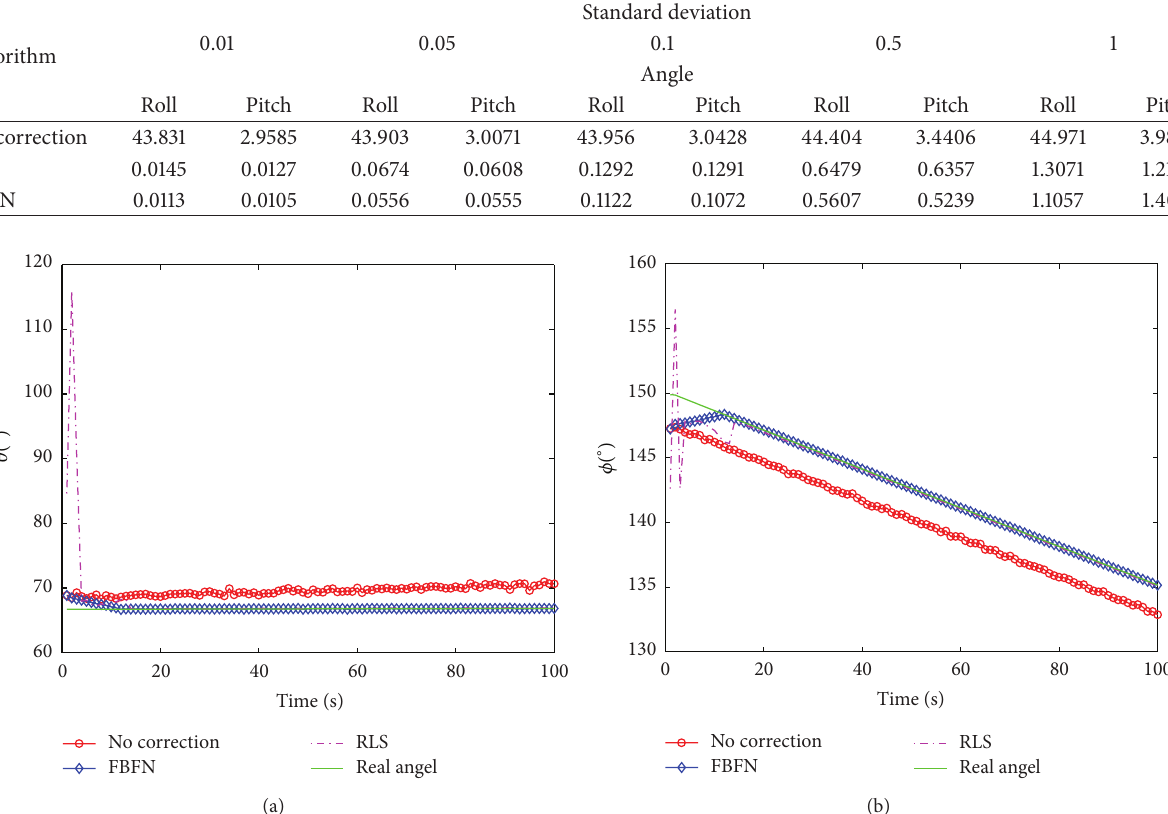
the 𝑌 -axis is the center. The rotational cycle time of the flight target is 209